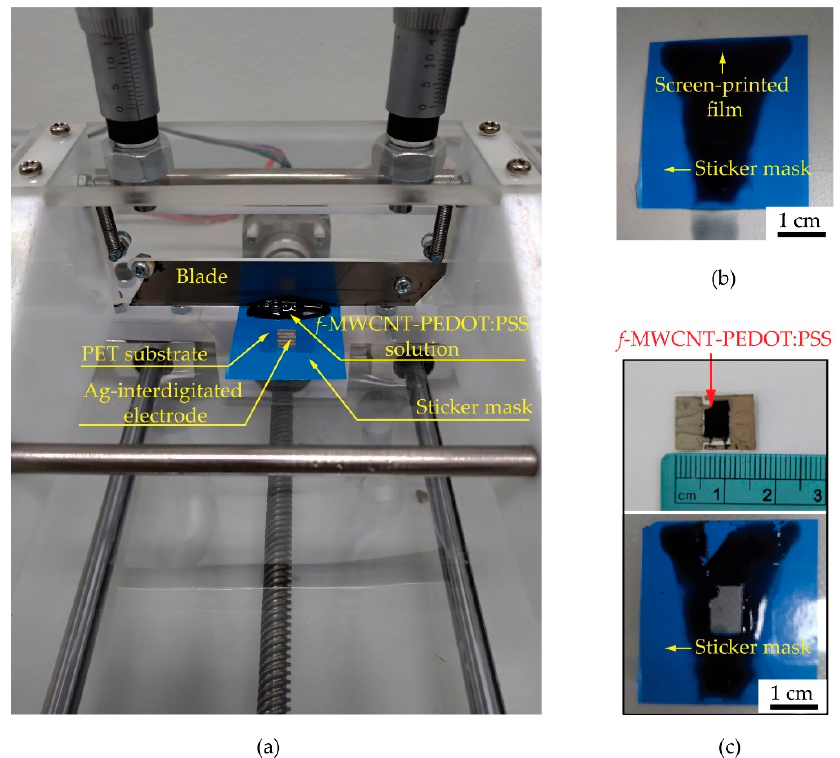
Figure 7. Photograph of ( a ) home-made doctor blade coater and its part. Screen-printed film of f -MWCNT-PEDOT:PSS gas sensor ( b ) before and ( c ) after peeling the sticker mask.